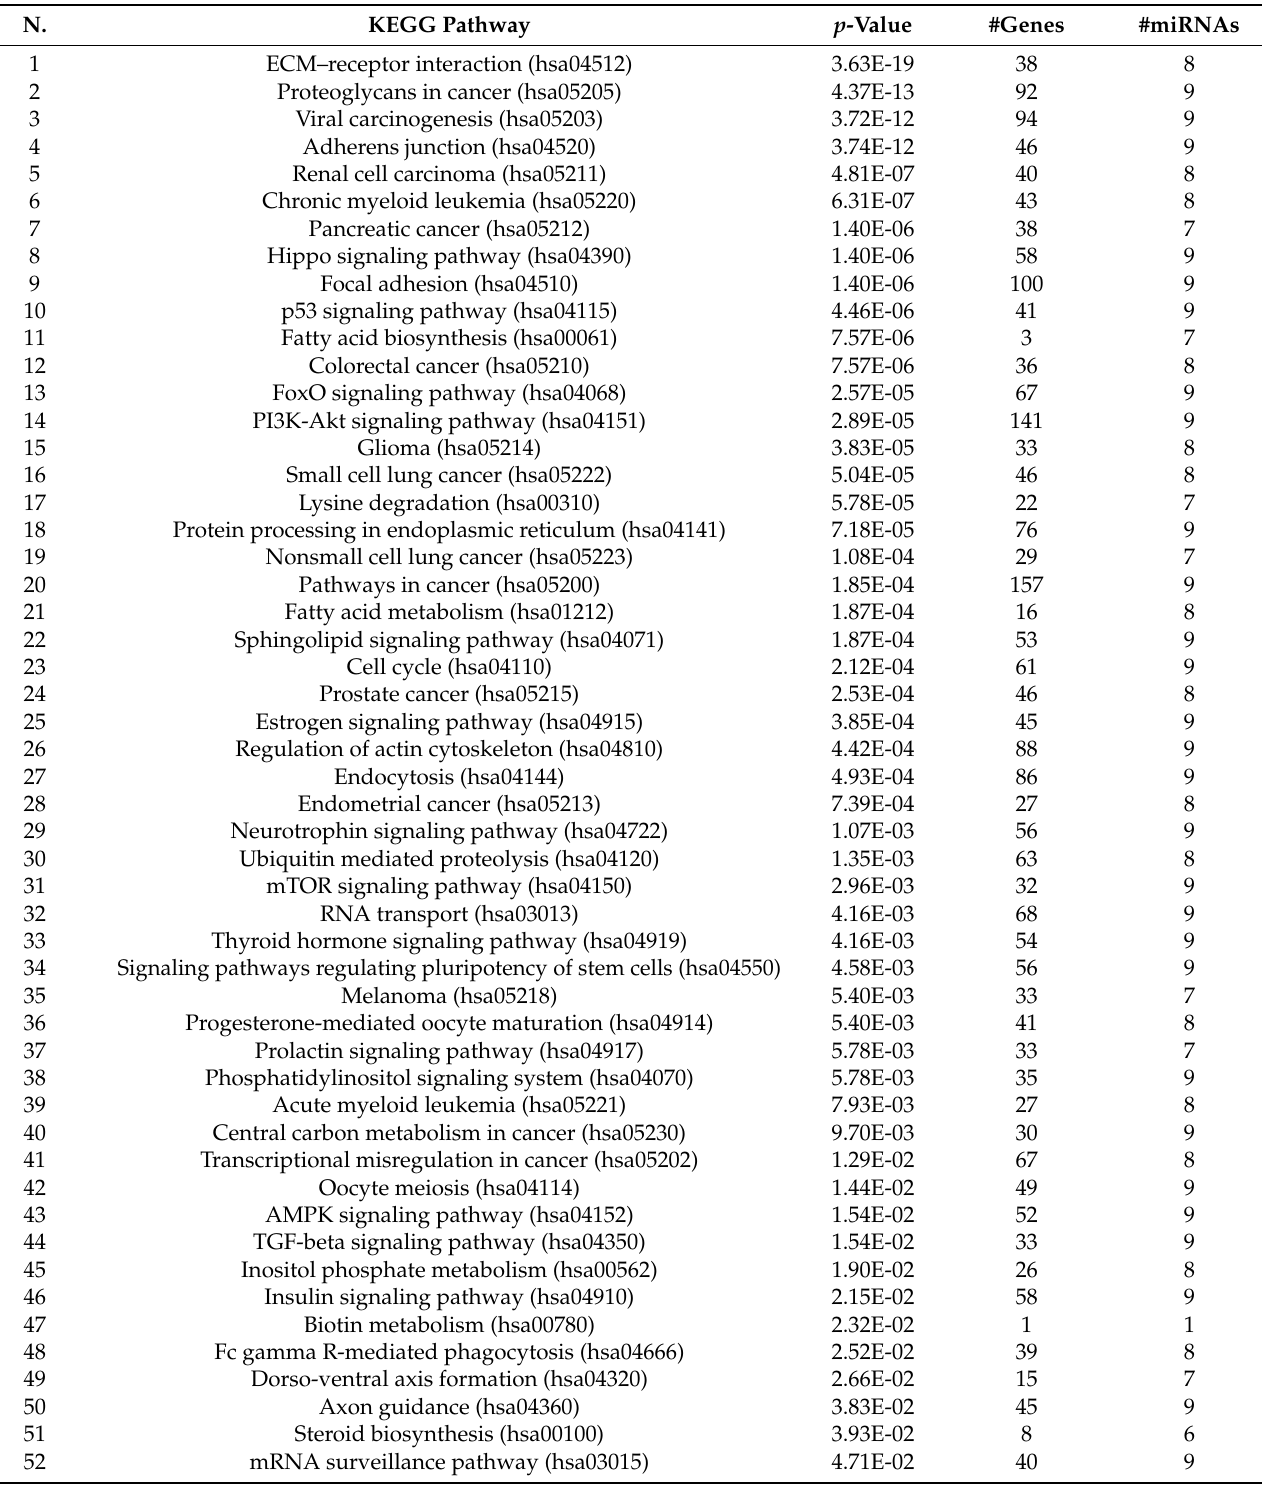
Table 4. Molecular pathways altered by the down-regulated miRNAs after pesticide exposure.